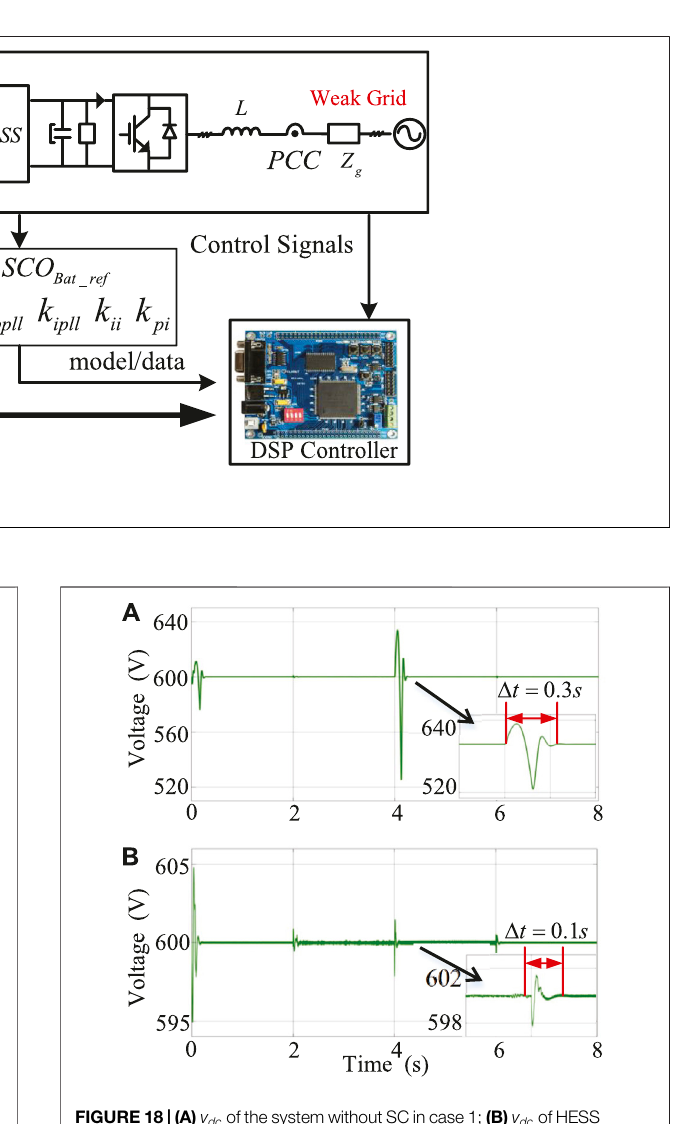
FIGURE18|(A) v dc ofthe system without SCincase 1; (B) v dc ofHESS in case